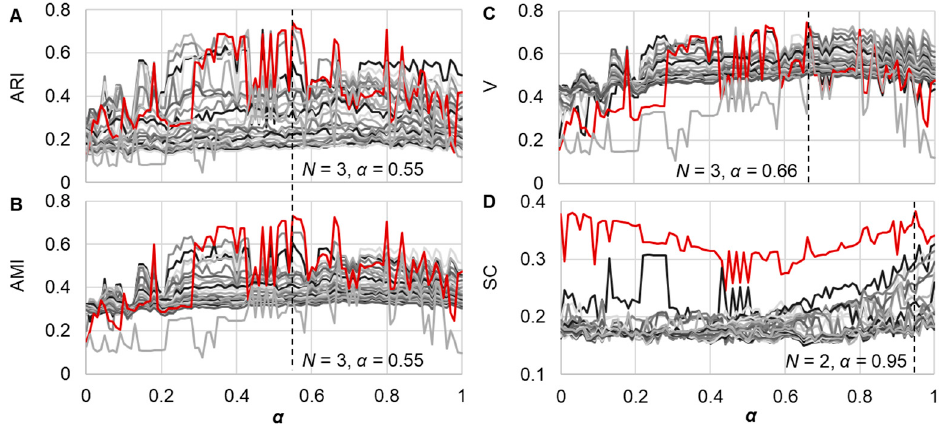
Figure 2. Similarity comparison with dynamic time warping (DTW) and derivative DTW (DDTW). The similarity of the growth curves was evaluated with DTW / DDTW, and the clustering was evaluated by four di ff erent statistical benchmarks, the adjusted Rand index (ARI) ( A ), adjusted mutual information (AMI) ( B ), the V-measure (V) ( C ), and the silhouette coe ffi cient (SC) ( D ) Each line represents the changes in the statistical benchmark along with the changes in the weight ratio ( α ) of DTW / DDTW under a certain number ( N ) of clusters. A total of 28 lines in gray gradation are shown for all four benchmarks, representing n = 2–28. The red lines represent the optimal N determined with the four statistical benchmarks. The best combinations of α and N decided by the statistical benchmarks are indicated with the broken lines and the insets.